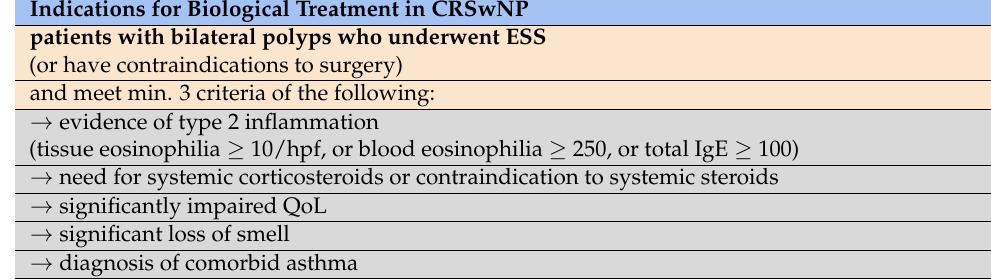
Table 1. Indications for biological treatment in CRSwNP according EPOS 2020 [2] (ESS—endoscopic sinus surgery, QoL—quality of